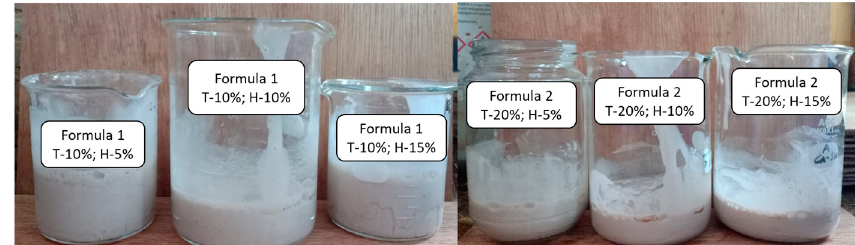
Figure 1. The PTH-based adhesive at different hexamine and tannin